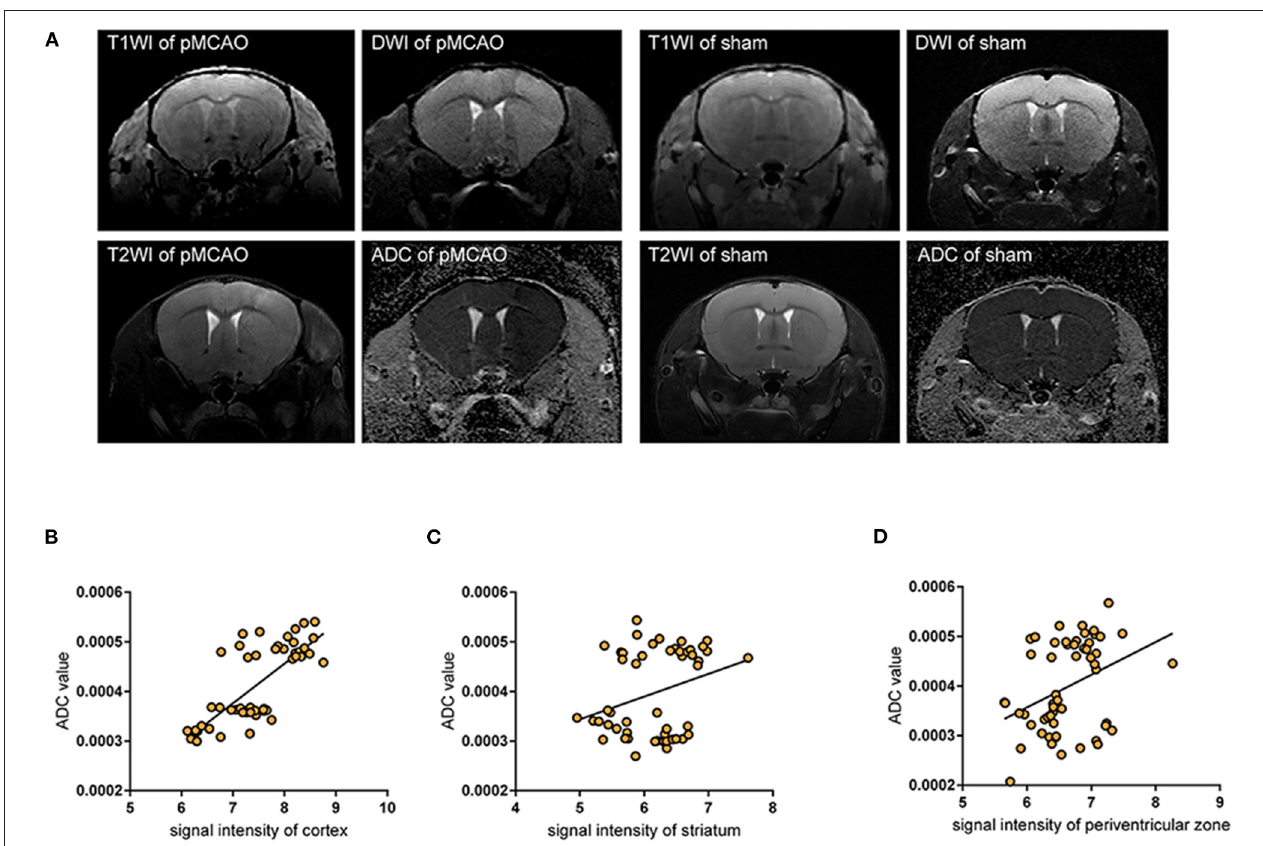
FIGURE 4 | Impaired glymphatic kinetics were correlated to ischemic edema in pMCAO as evaluated by 11.7T MRI. (A) Representative T1W images, DWI, and ADC maps of pMCAO and sham-operated animals with BOPTA-Gd injection, and T2W images of cerebral ischemia at ∼ 150 + 28min after pMCAO. L indicates the damaged side. (B–D) The corresponding quantifications of T1W SI in the cortex (B) , striatum (C) , and periventricular zone (D) were positively correlated to ADC values in pMCAO and the sham-operated animals by MR scan. The serial acquisition of MR images was performed by an interval of about 12min, started at 28min after pMCAO and 14min after BOPTA-Gd injection. The correlation analysis indicated that the progression of ischemic edema was consistent with the impaired glymphatic transport kinetics after cytotoxic edema appeared, as evaluated by